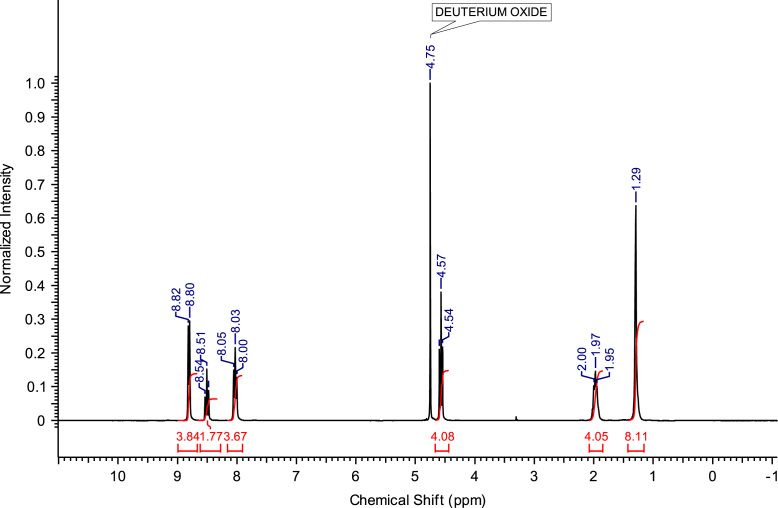
1H NMR spectra of C8(Pyr)2Br2.